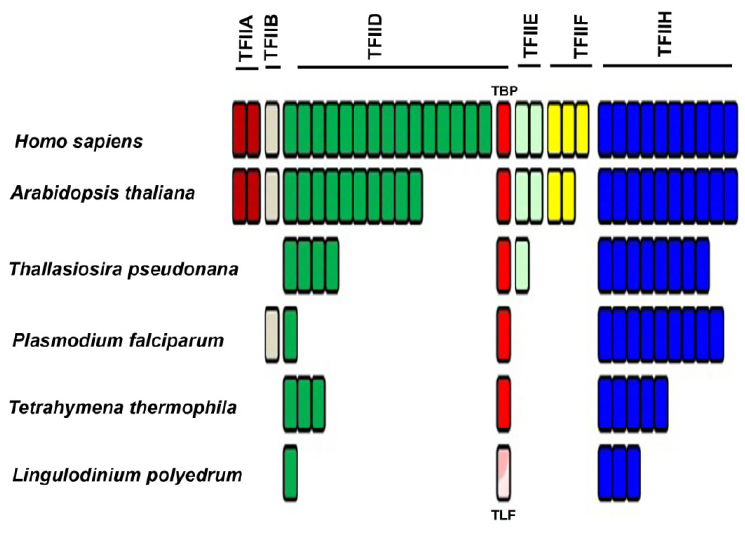
Figure 5. Phylogenetic distribution of transcription factors associated with RNA-polymerase II shows a marked decrease in the number of TFII members among the